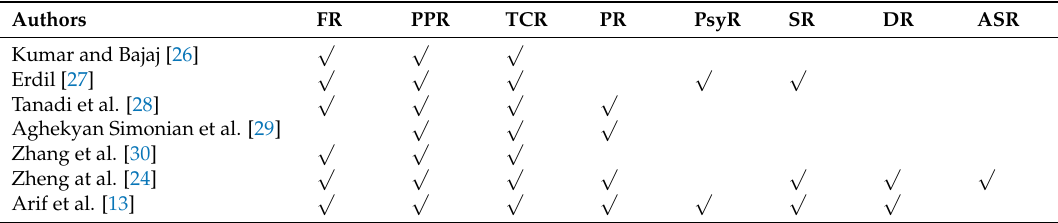
Table 1. The variables of perceived risk in past